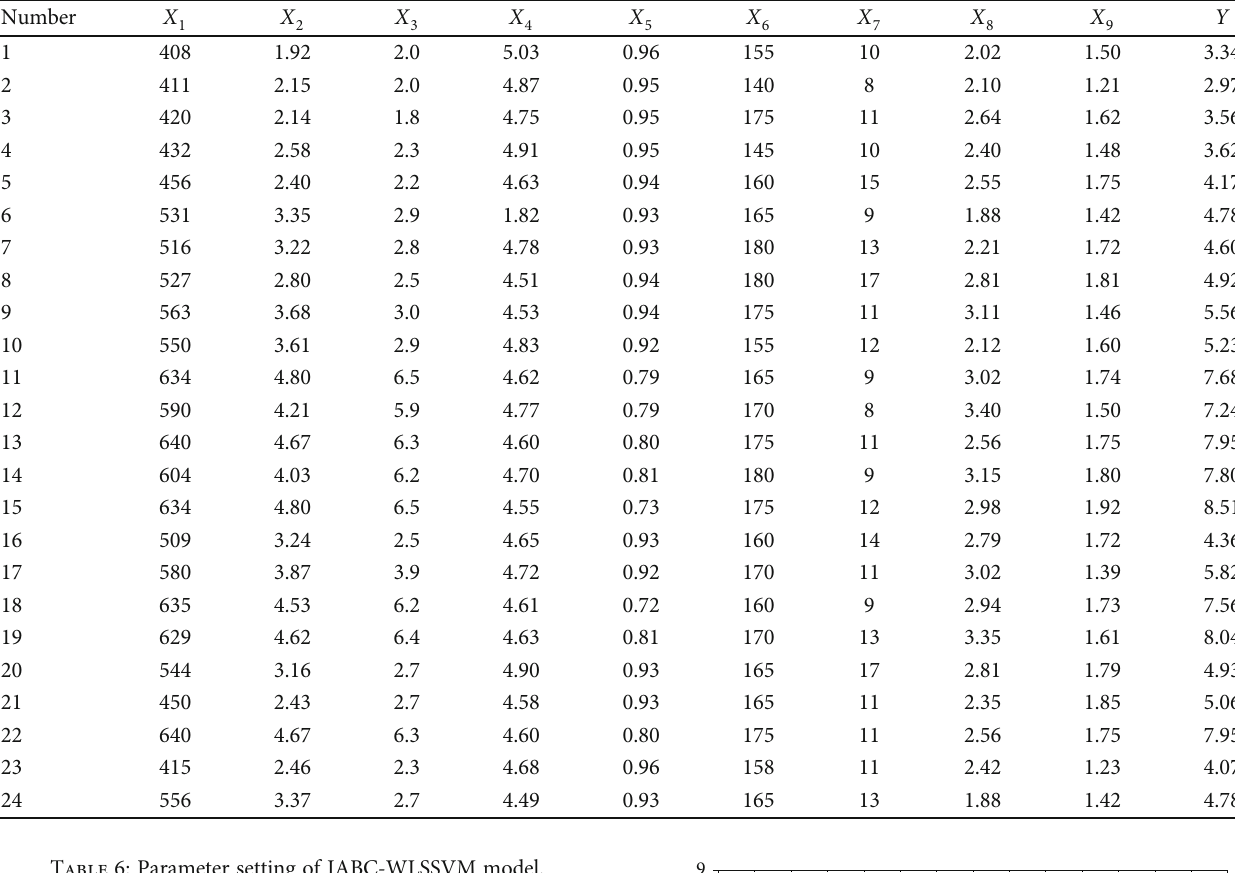
Table 5: Original data of 9 main factors.